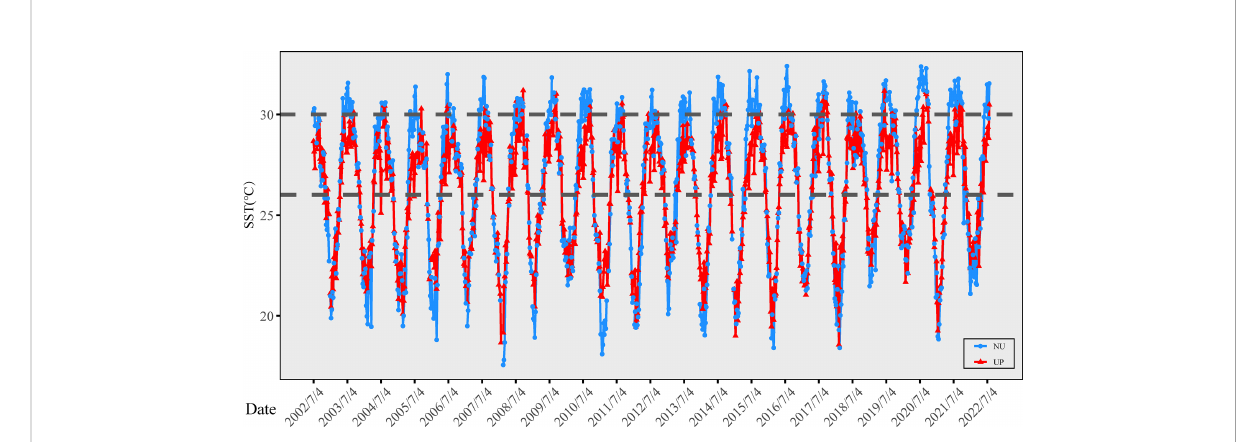
FIGURE 2 Temporal SST with a resolution of 8 days at the eastern and northwest coast of Hainan Island from 2002 to